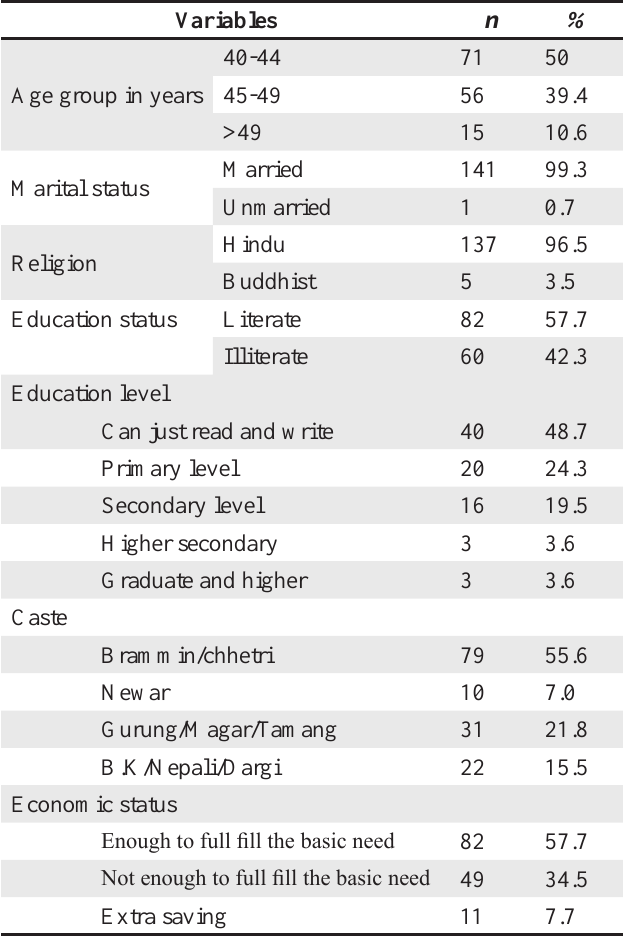
Table 1 : Socio-demographic Characteristics of Respondents